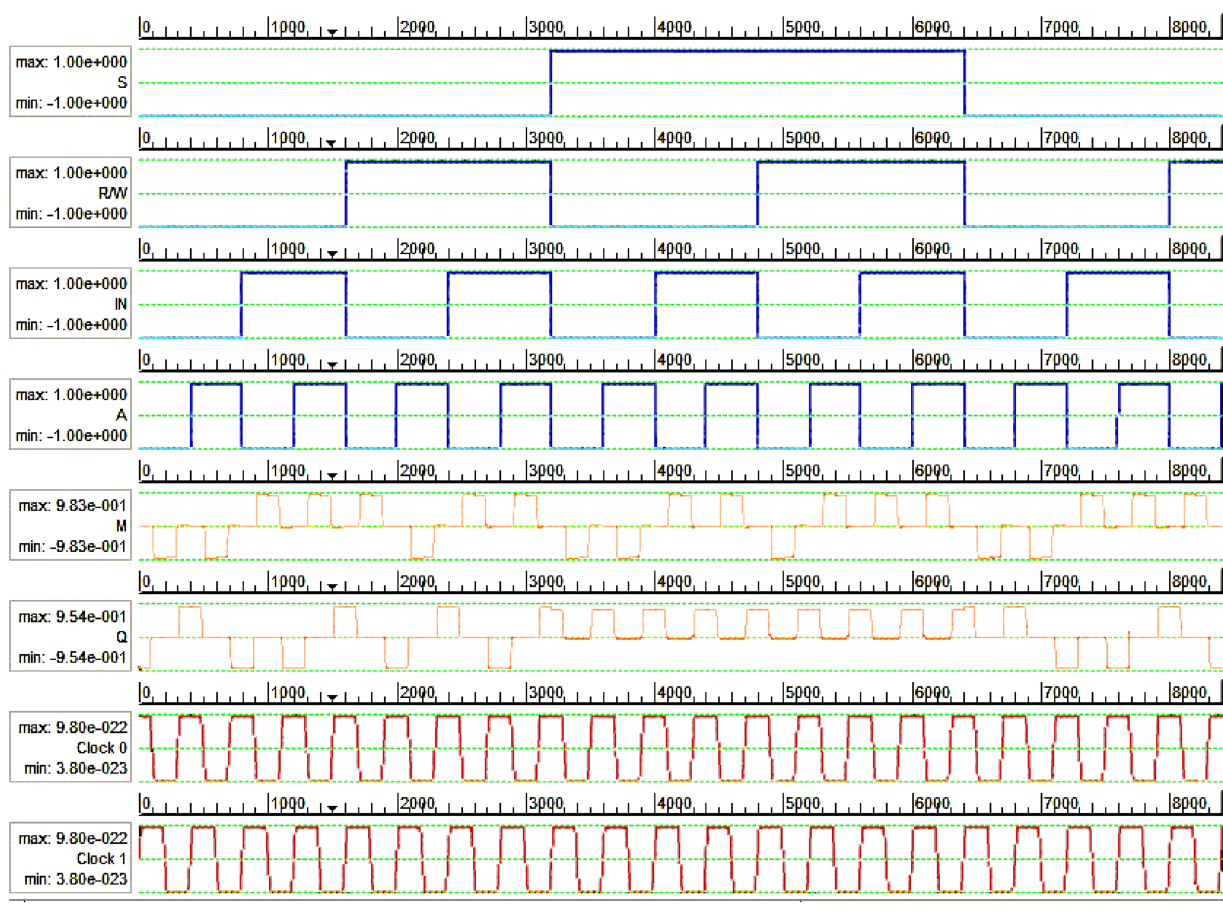
Fig. 16 The results of the designed content-addressable memory circuit